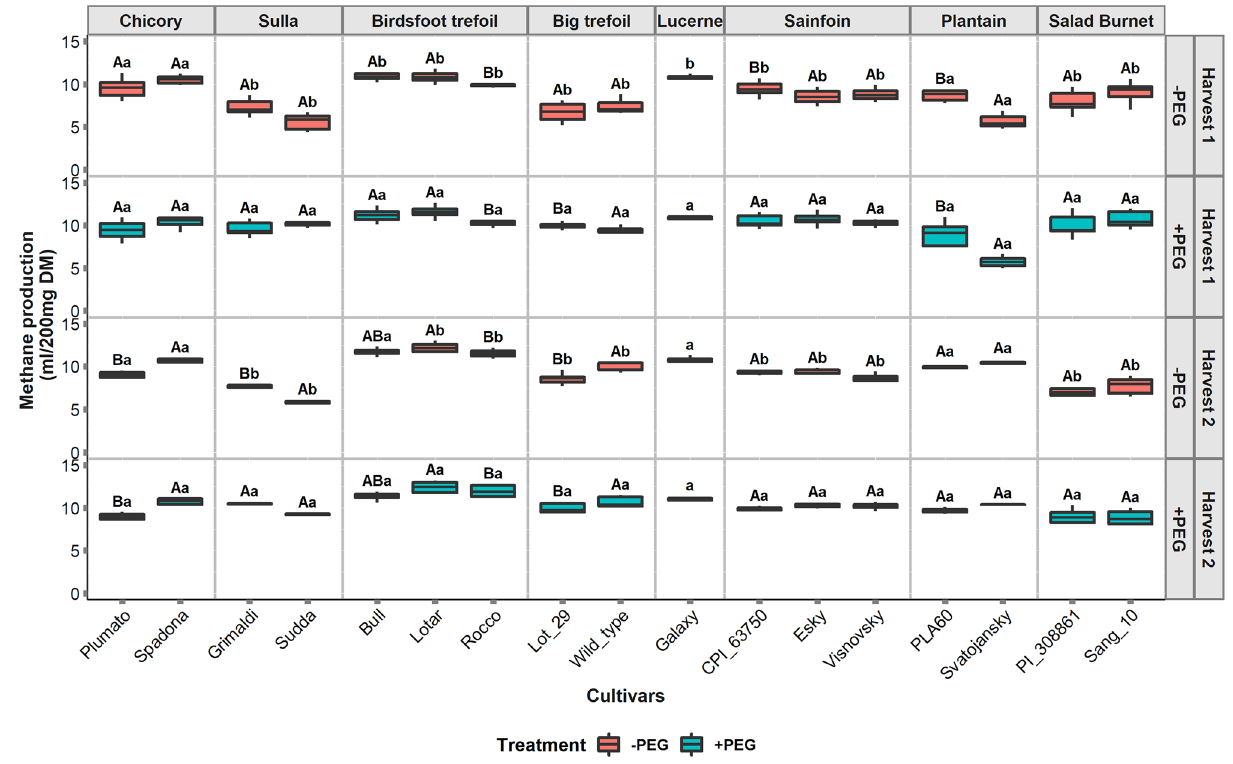
Figure 3. Methane production from 17 cultivars of 8 species under different treatments for two harvests. −PEG indicates the samples incubated without polyethylene glycol (PEG) and + PEG refers to the samples incubated with PEG. Different uppercase letters represent significant differences ( P < 0.05) between the cultivars for each species, and different lowercase letters represent the significant differences within the treatments for each